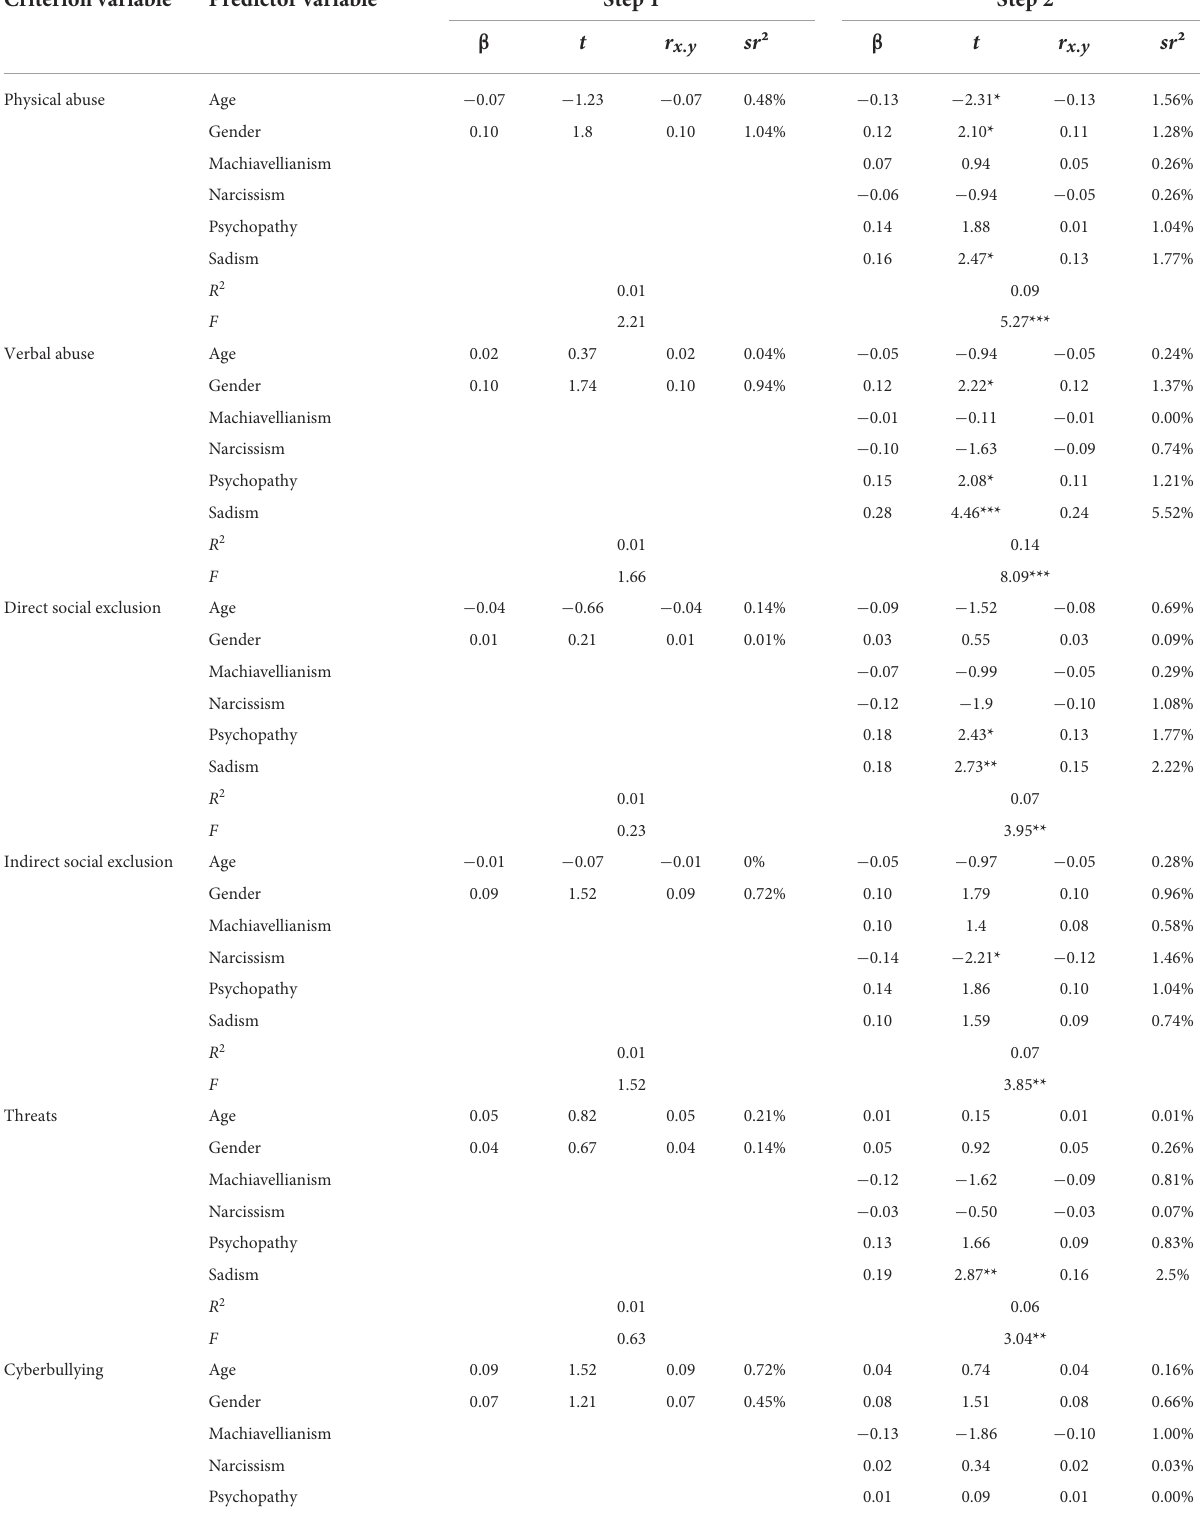
TABLE 3 The predictive capacity of the Dark Tetrad for bullying as victimization. Criterion